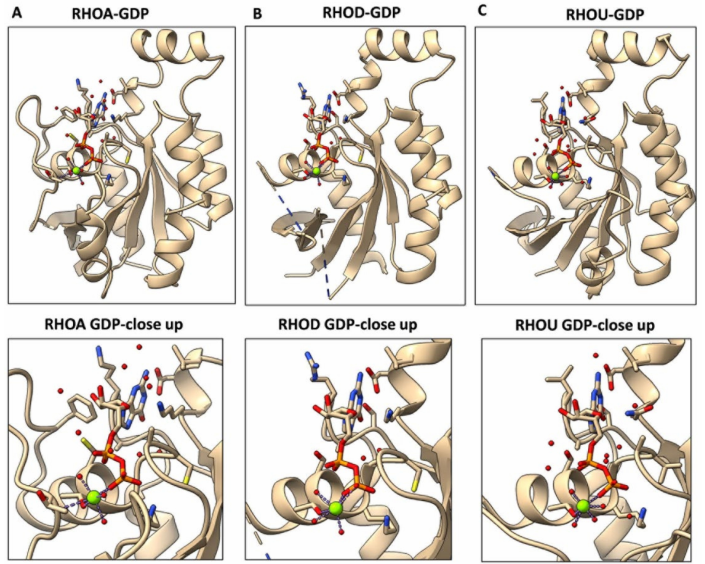
Figure 3. Three-dimensional structures of GDP-bound RHOA, RHOD, and RHOU. Structural information was collected from the PDB database, and are displayed for RHOA-GDP, 1FTN ( A ), RHOD-GDP, 2J1L ( B ), and RHOU-GDP, 2Q3H ( C ). Top: Overview. Bottom: Close-ups of GDP positioning. Images were generated with the USCF ChimeraX software (version 1.2, http://www.rbvi.ucsf.edu/chimerax) (version: 1.2.5 (24 May